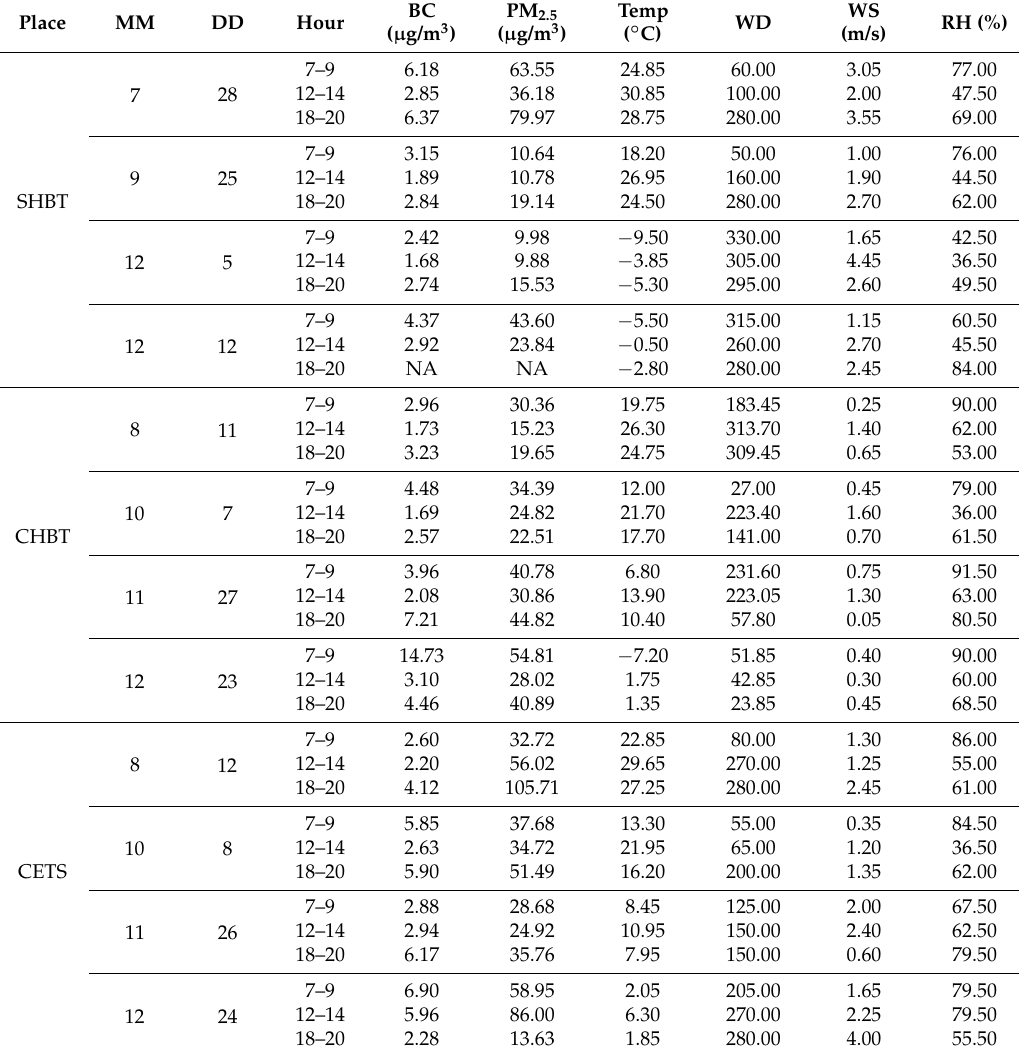
Table A1. Summary of the hourly BC and PM 2.5 concentrations with meteorological conditions per each sampling place during the sampling